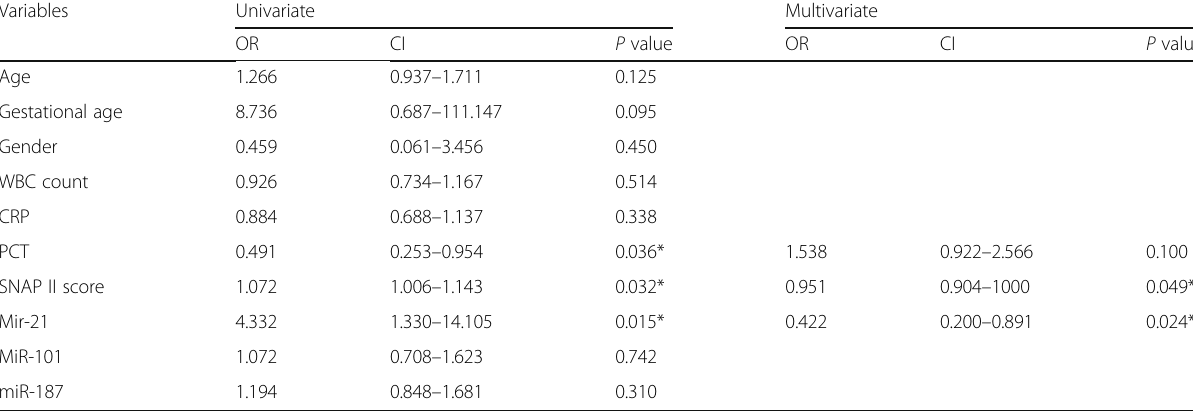
Table 4 Logistic regression analysis of miRNAs 101, 187, and 21 and the clinical parameters between sepsis survivors and non-